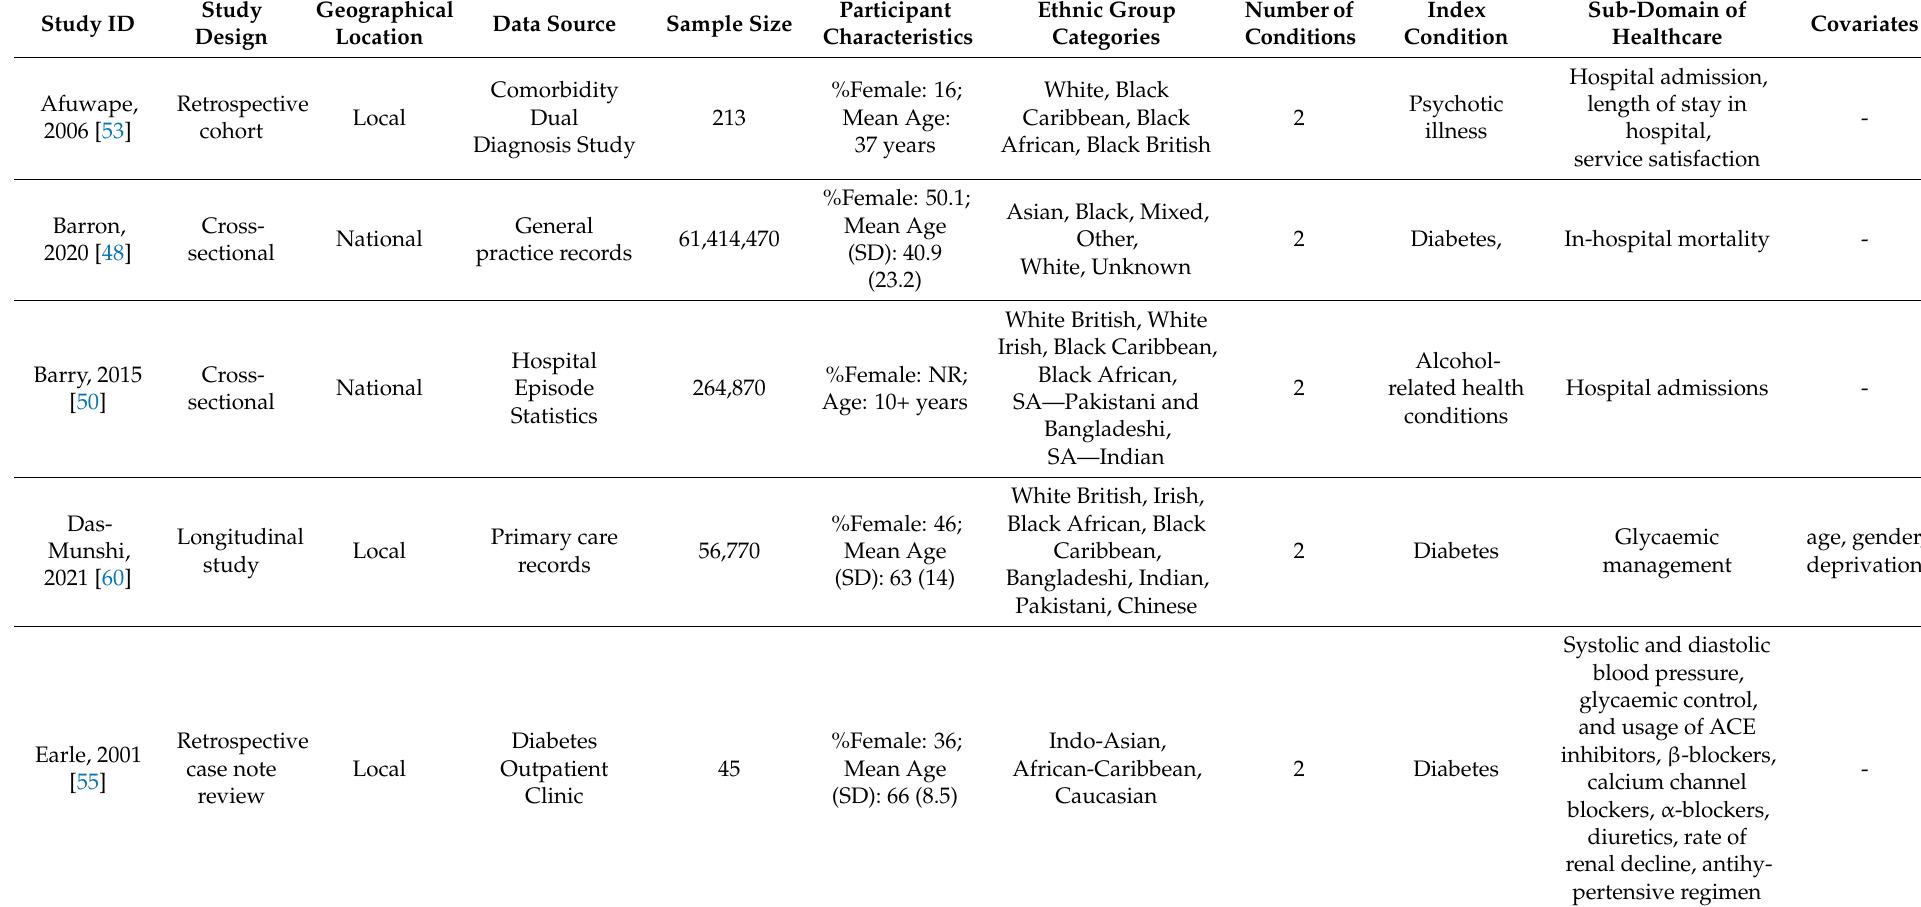
Table 2. Characteristics of included